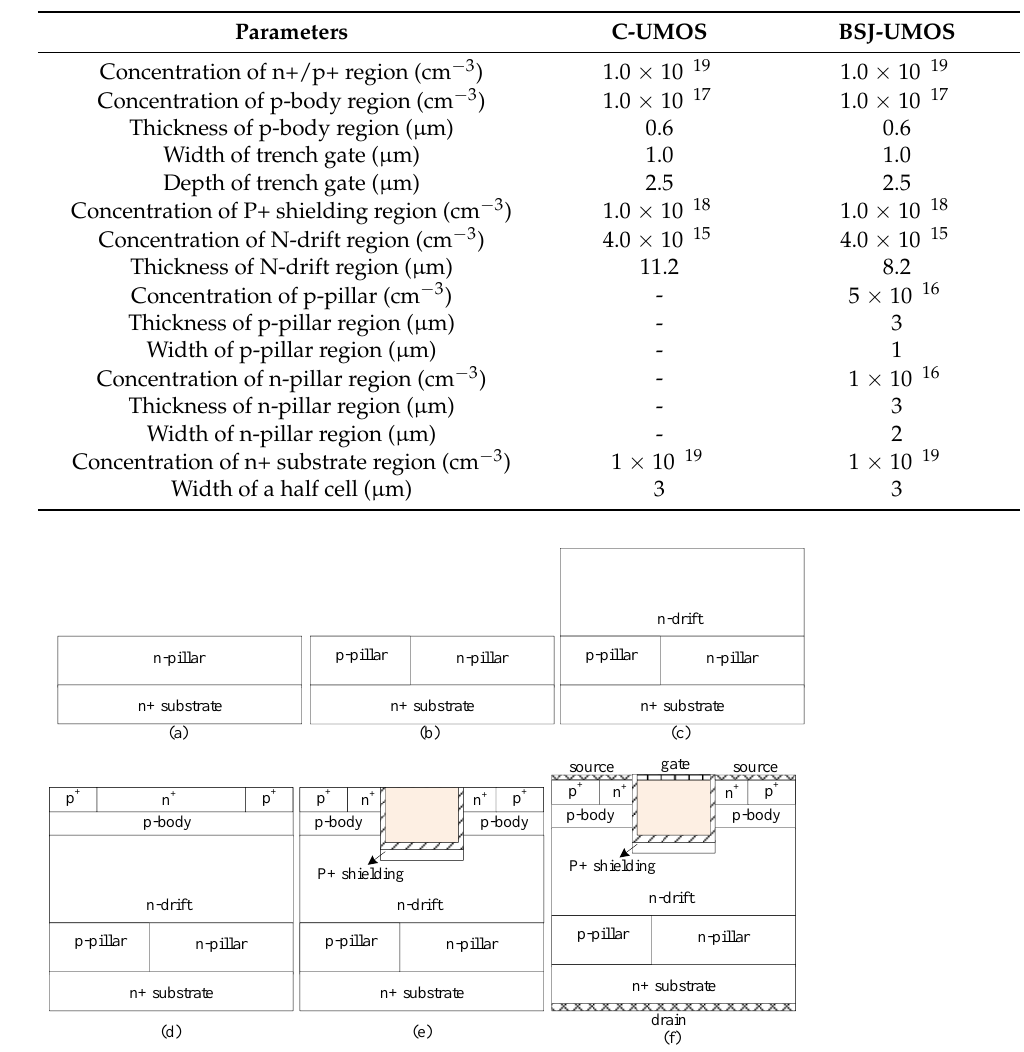
Figure 2. A possible fabrication process for BSJ-UMOS ( a ) growth of the n-pillar layer on n+ substrate ( b ) growth of the p-pillar layer by ion implantation ( c ) growth of the n-drift layer ( d ) growth of the p-body, n+ source and p + contact regions ( e ) forming the trench gate structure ( f ). metalizing all contacts